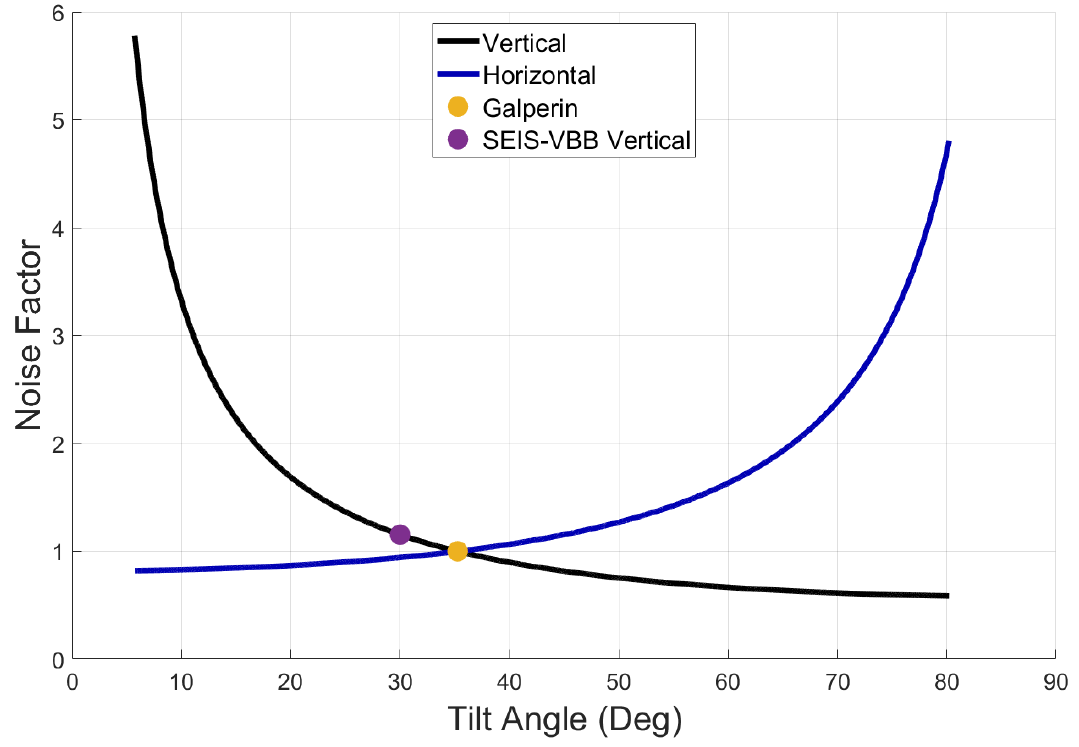
Figure 4. The dimensionless noise factor for a triaxial seismometer for reporting a single horizontal or vertical axis. or vertical